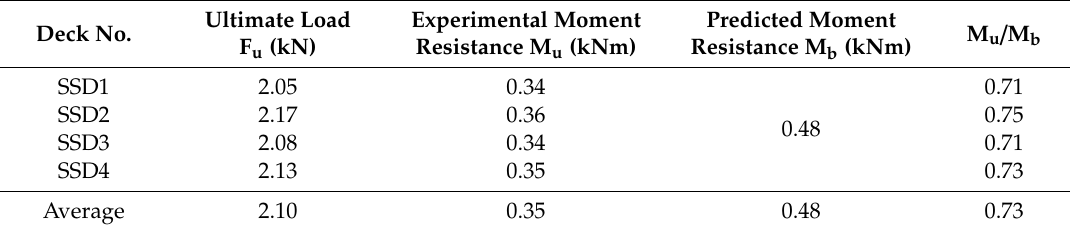
Table 4. Experimental and calculated results for single-span decks (experiment group (b)). Deck